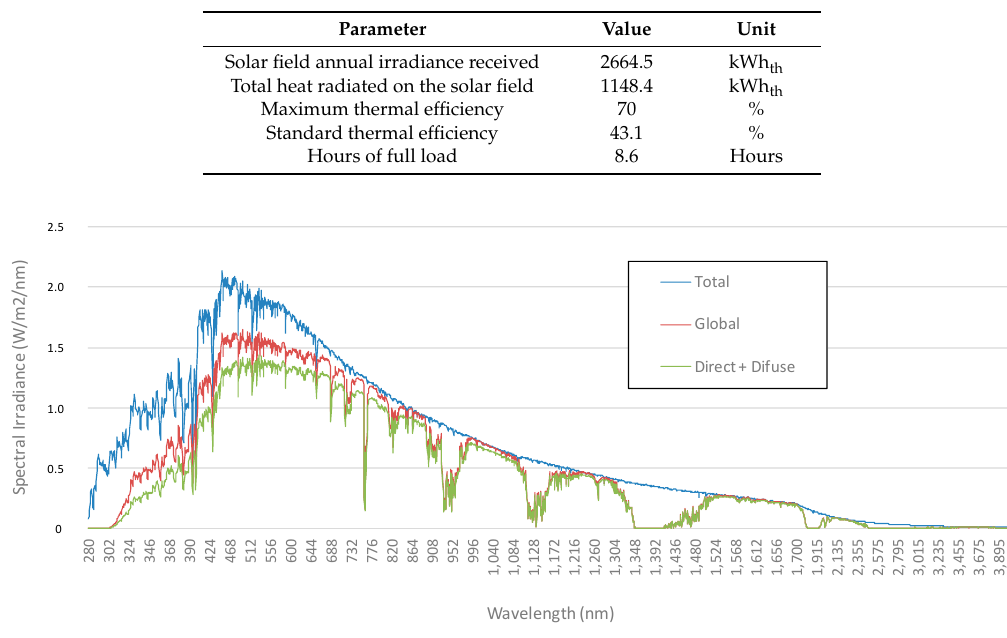
Table 1. Main solar radiation data per square meter.